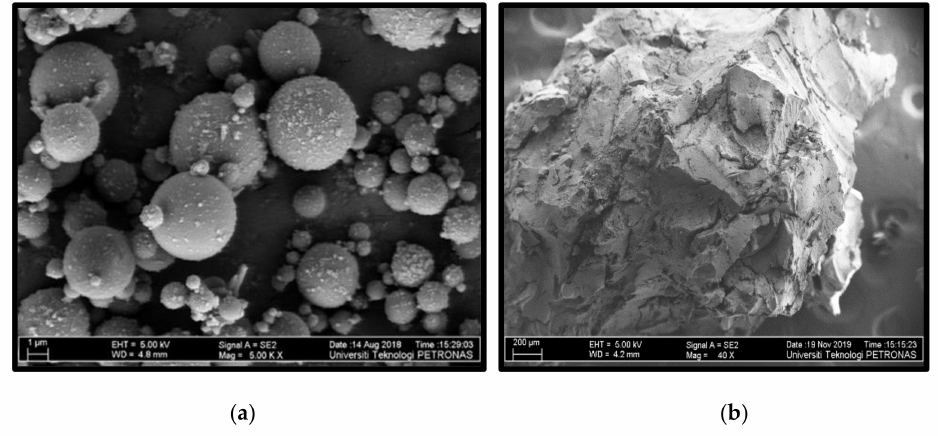
Figure 5. FESEM images showing the ( a ) spherical shape of the FA particles [29] and ( b ) the rough surface texture of the